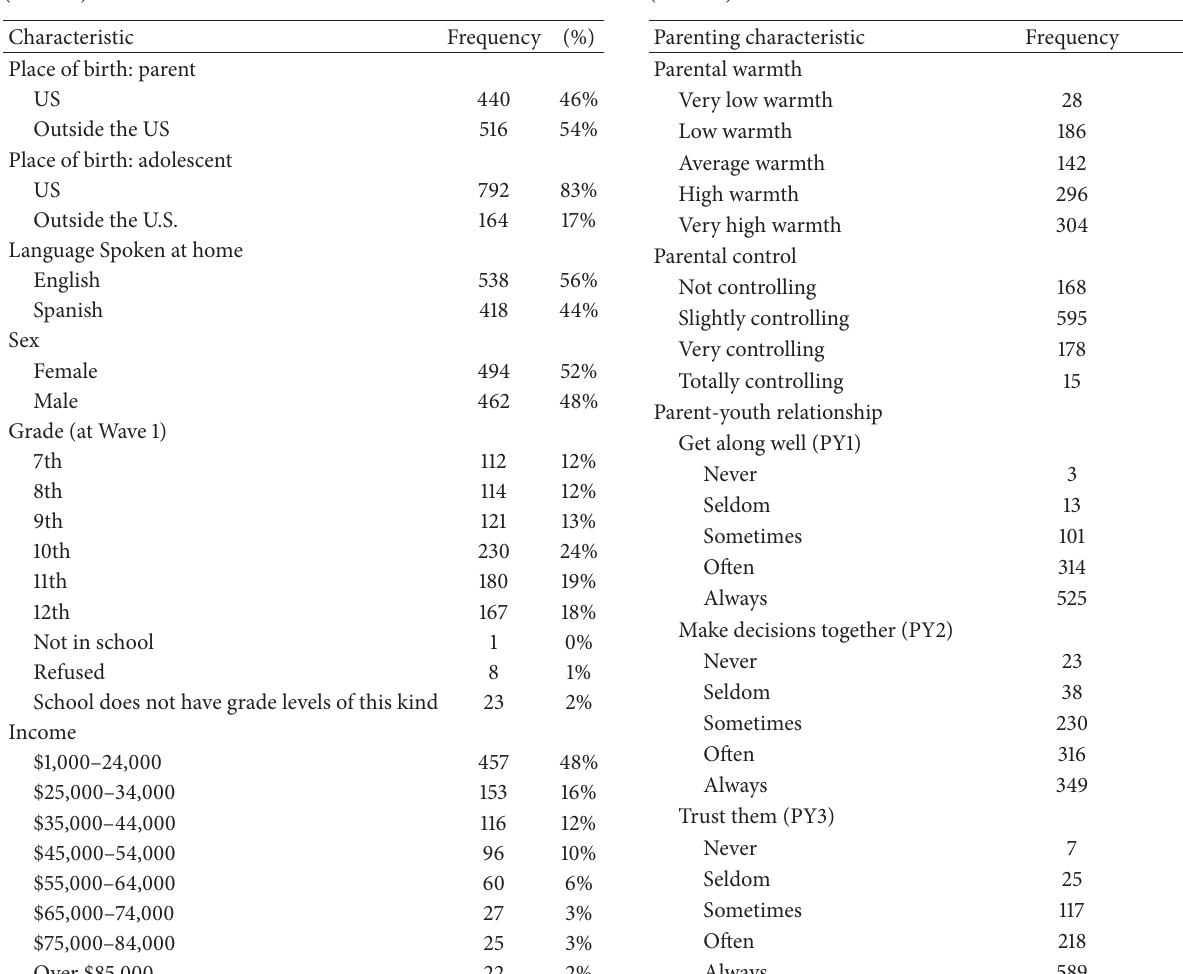
Table 1: Descriptive characteristics of Mexican American youth ( 𝑛 = 956 ).